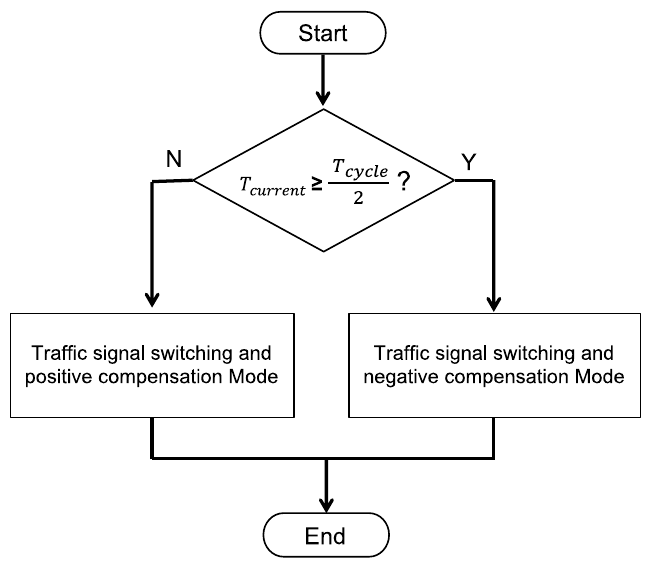
Figure 13. Traffic signal switching and compensation mode. Figure 13. Tra ffi c signal switching and compensation